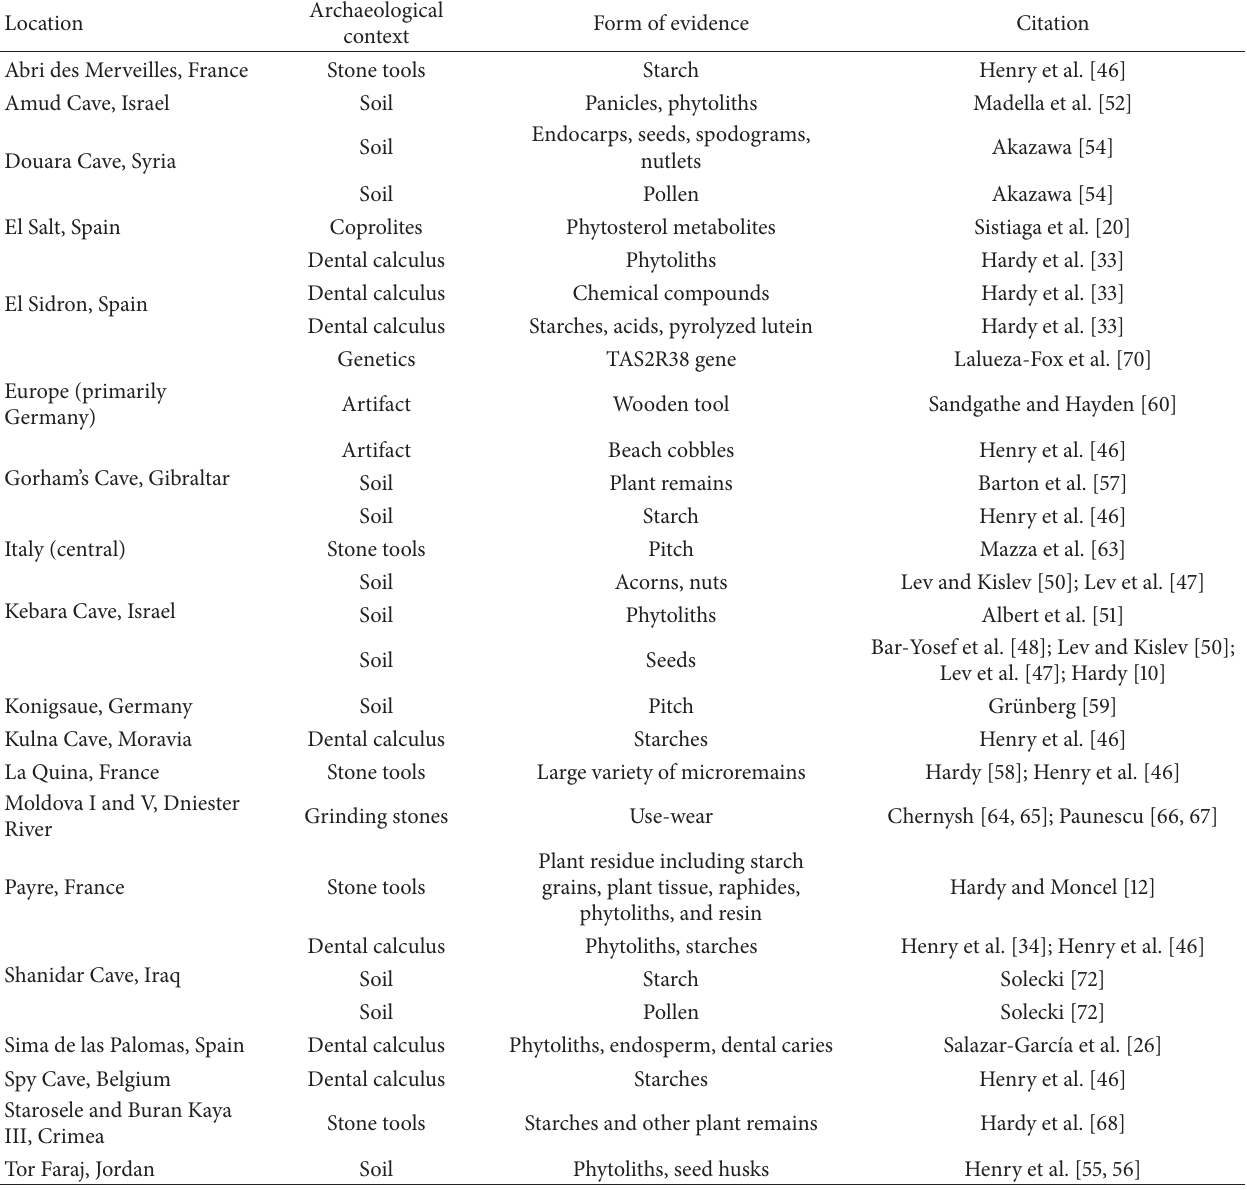
Table 1: Archaeological contexts and forms of evidence for plant use by Neanderthals at various